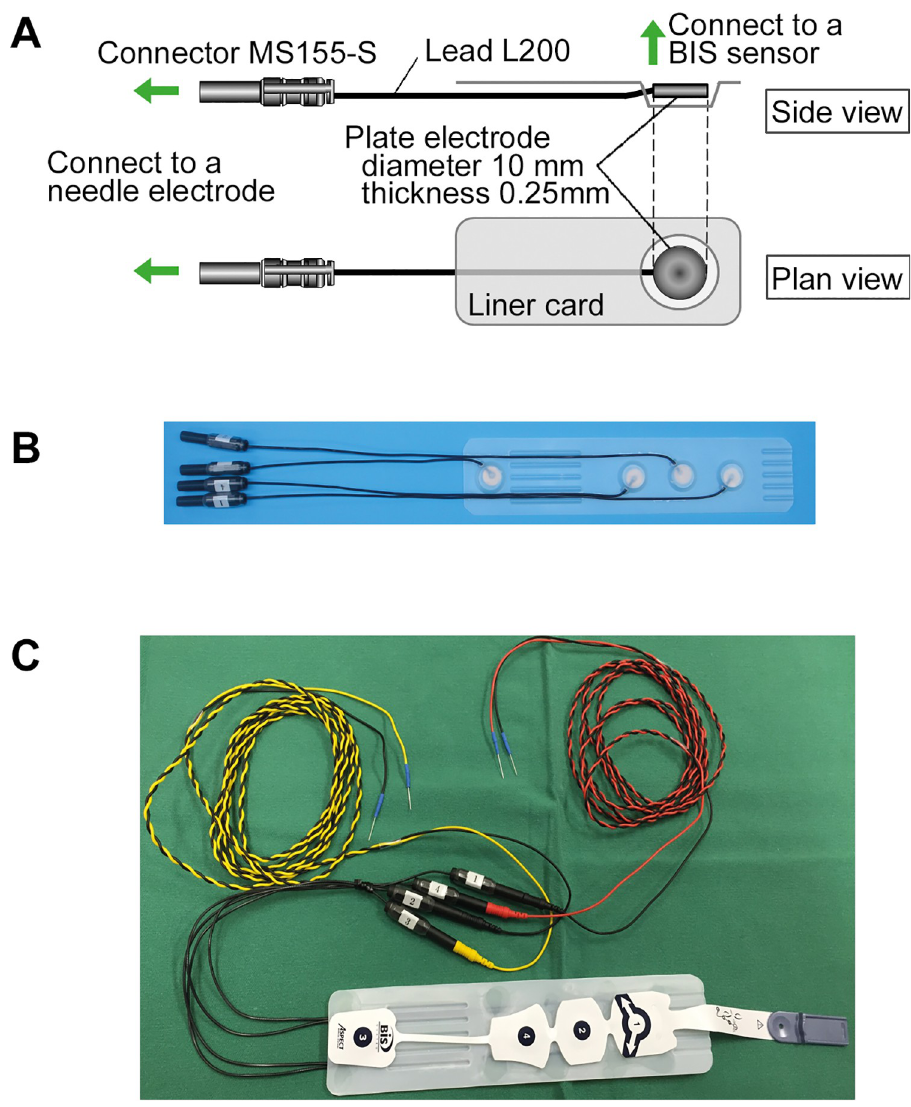
Fig 1. The interface device. (A) Specifications of the interface device. (B) The interface device. Four electrodes are integrated into a silicone-coated high-impact polystyrene liner card. (C) The interface device connected to the needle- electrodes and a BIS ™ Quatro sensor. BIS: bispectral